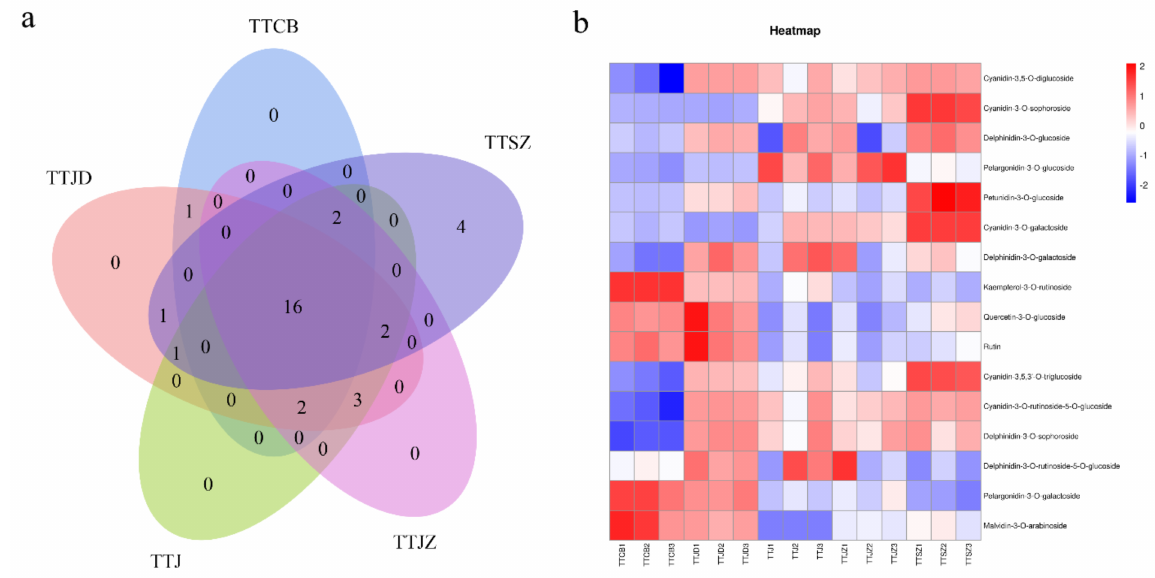
Figure 3. Analysis of the metabolome results. ( a ) Venn diagram of metabolite expression in different coloured flower samples. Different groups are represented by different colours. ( b ) Heatmap of coexpressed metabolites in flower samples of different colour; the numbers are Z-score values of